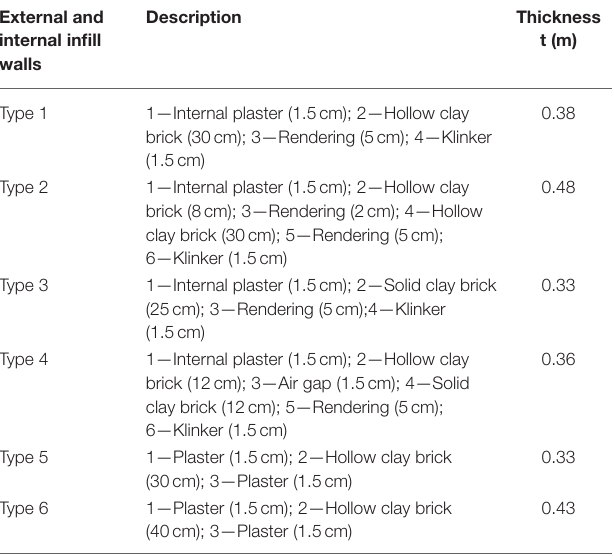
TABLE 1 | Typologies of infill walls and partition.